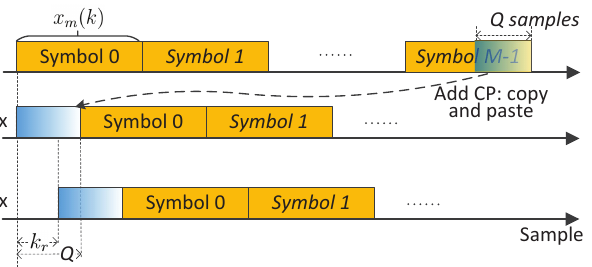
Figure 2. Illustrating the signal timing in RCP-OTFS sensing, where, different from OFDM shown in Figure 1, only a single CP is added to a whole block of